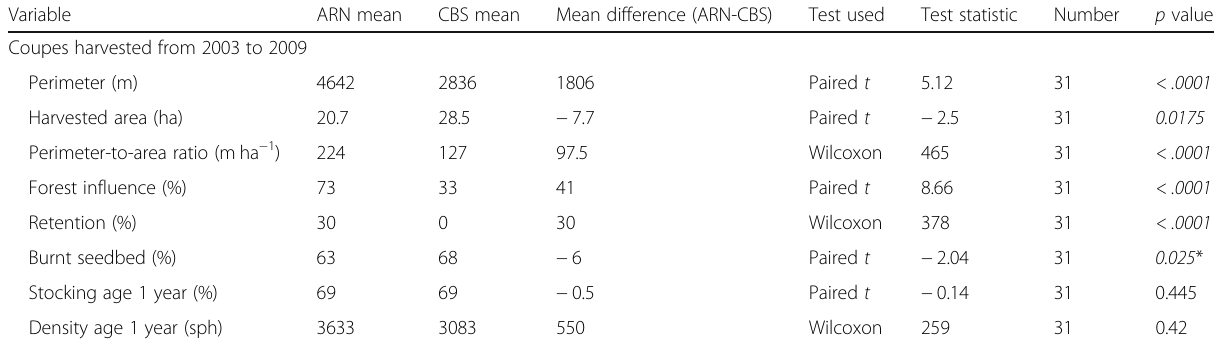
Means for each silvicultural system are shown as well as the mean difference between the paired coupes (ARN – CBS). Tests used, test statistics, and p values are shown, with significant difference indicated in italics. Reprinted from Scott et al. (2012b) and Scott et al. (2013), with permission from Elsevier, and from Scott et al. (2015), with permission from Taylor & Francis (https://www.tandfonline.com/) *One-tailed p